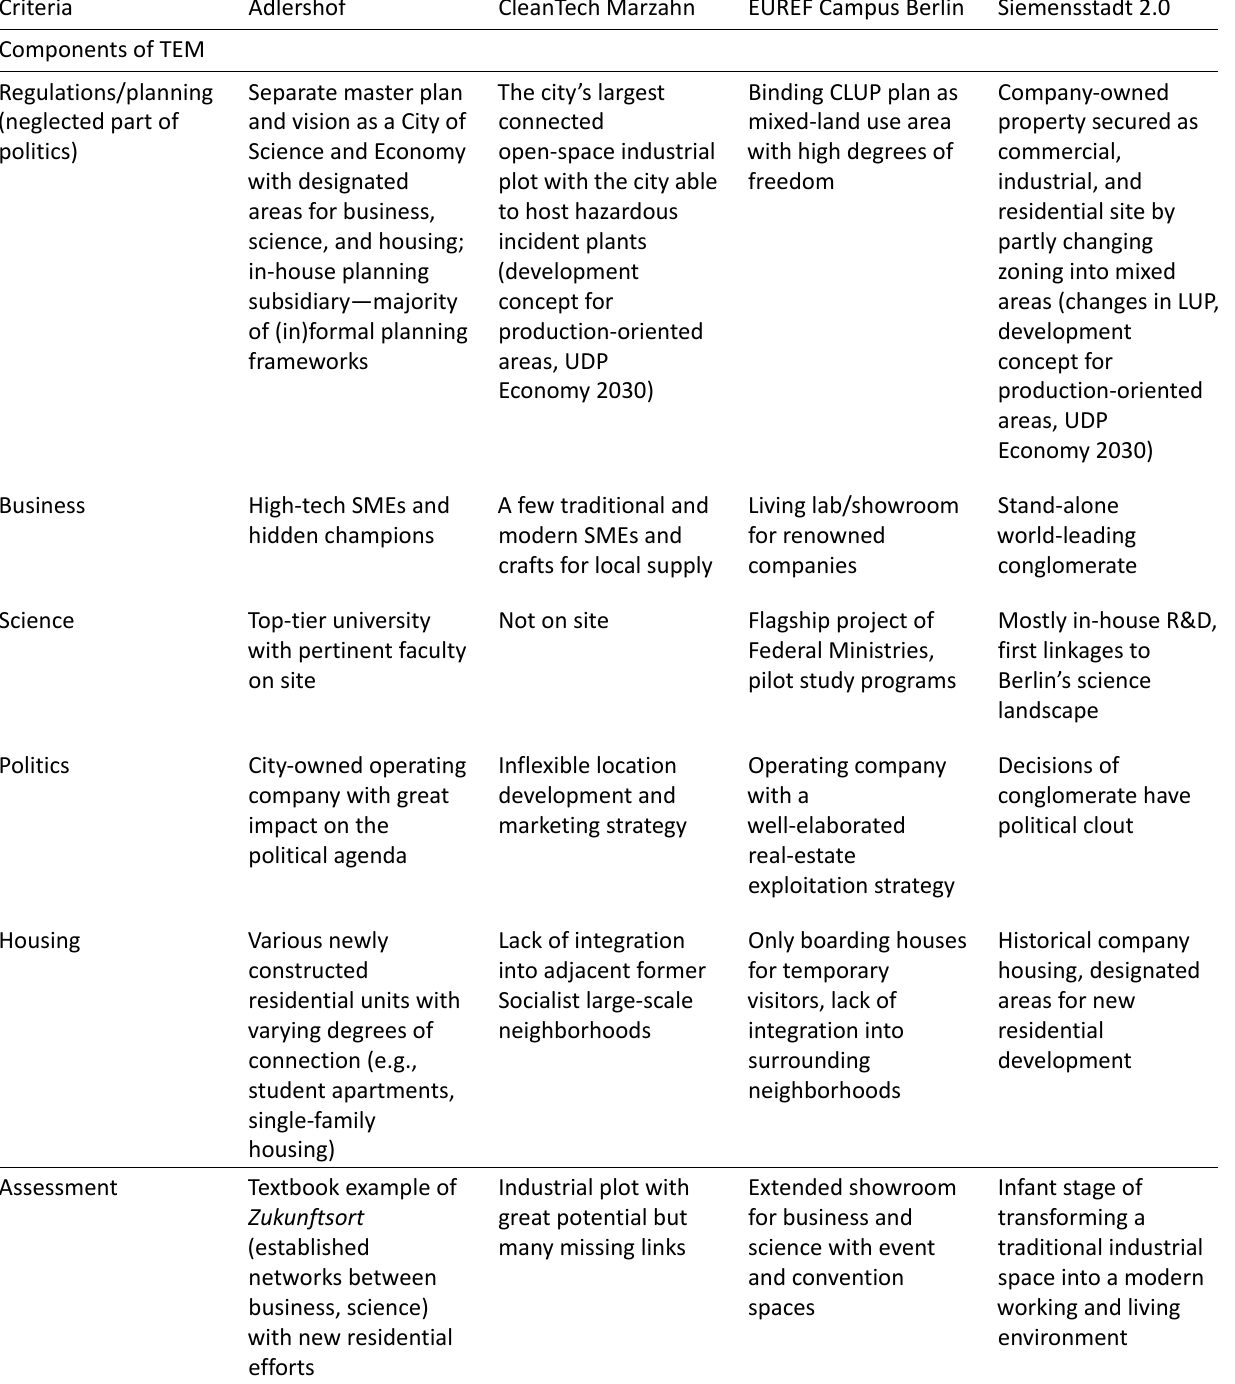
Table 1. Characteristics of the case studies.